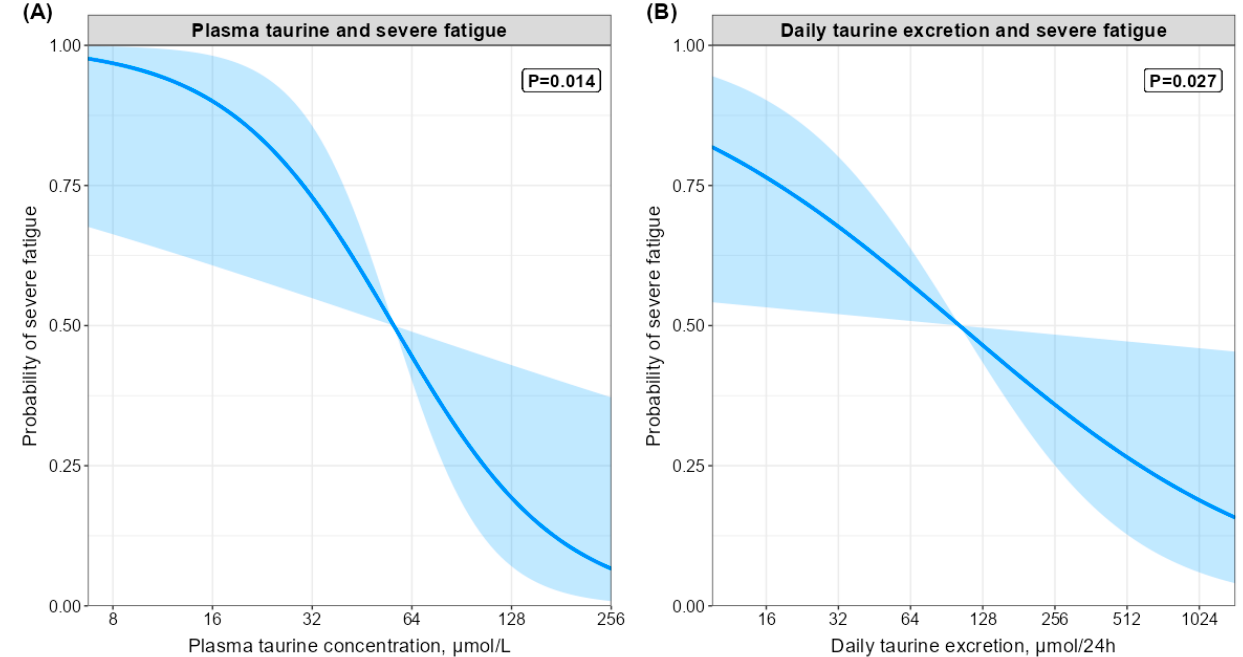
Figure 2. Graphical representation of the association of plasma taurine ( A ) and daily taurine excretion ( B ) with the probability of severe fatigue. The analyses are adjusted for age, sex, body mass index, dialysis vintage, hemoglobin concentration, C-reactive protein concentration, presence of cardiovascular disease, and presence of diabetes.